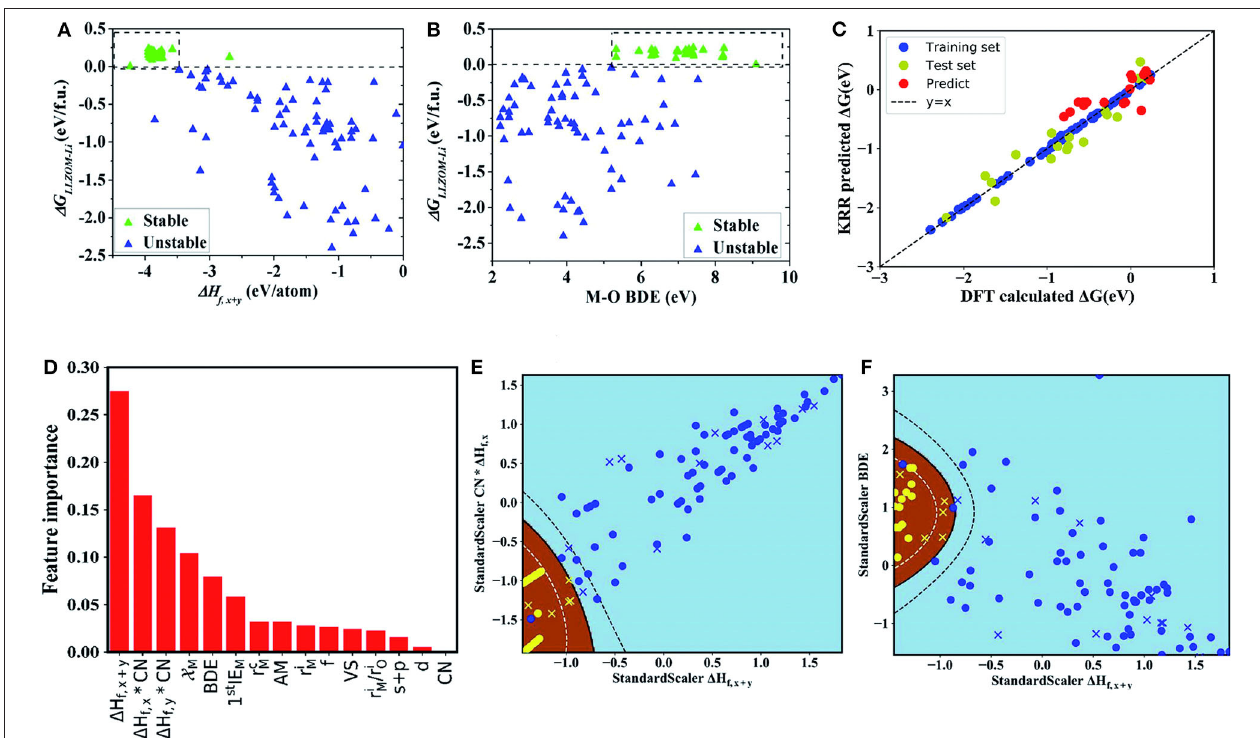
FIGURE 4 | The dependence of the reaction energy 1 G LLZOM − Li of Li|LLZOM interface on (A) 1 H f,x + y , and (B) M-O bond dissociation energy. The most appropriate range for each feature is shown by dotted boxes. (C) The predicted reaction energies using a KRR model compared with DFT calculated reaction energies ( 1 G). The model is trained on a randomly selected 80% training set from the 100 LLZOM database using the 15 features. The mean squared error (MSE) and the coefficient of determination ( R 2 ) are calculated to estimate the prediction errors. The test and training points are displayed in green and blue, respectively. The black dashed line represents the perfect correlation line. (D) Rank the importance of 15 selected features using the random forest algorithm. Maps of (E) CN × 1 Hf,x and 1 H f,x + y , and (F) 1 H f,x + y , and M-O bond dissociation energy (BDE) feature pairs for 100 LLZOM compounds considered in our work. Meanwhile, we predicted and plotted 18 unexplored data points, and represented them by yellow crosses and blue crosses. 100 training data points are represented by yellow circles and blue circles. Sky-blue and brown areas represent thermodynamically unstable and stable regions, respectively. Reprinted with permission from Liu et al. (2019). Copyright (2013) Royal Society of Chemistry (Great